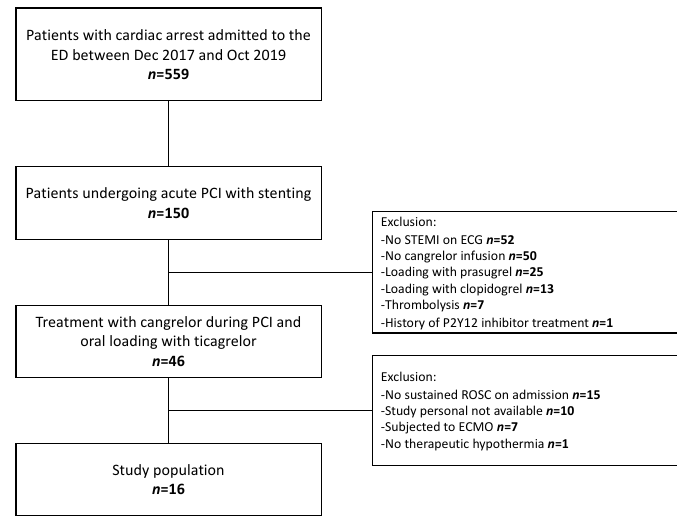
Figure 1. Flowchart of the study.